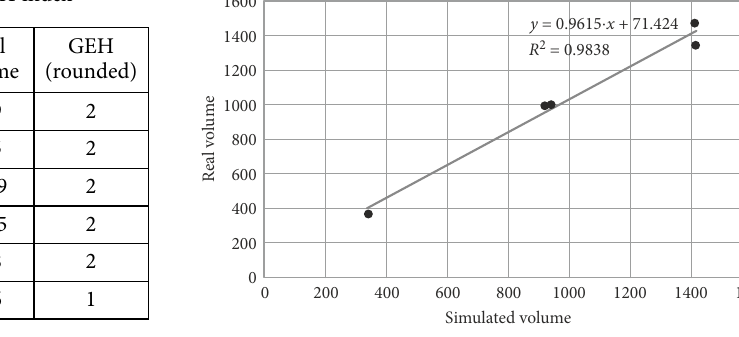
Figure 9. NAÏVE approach validation